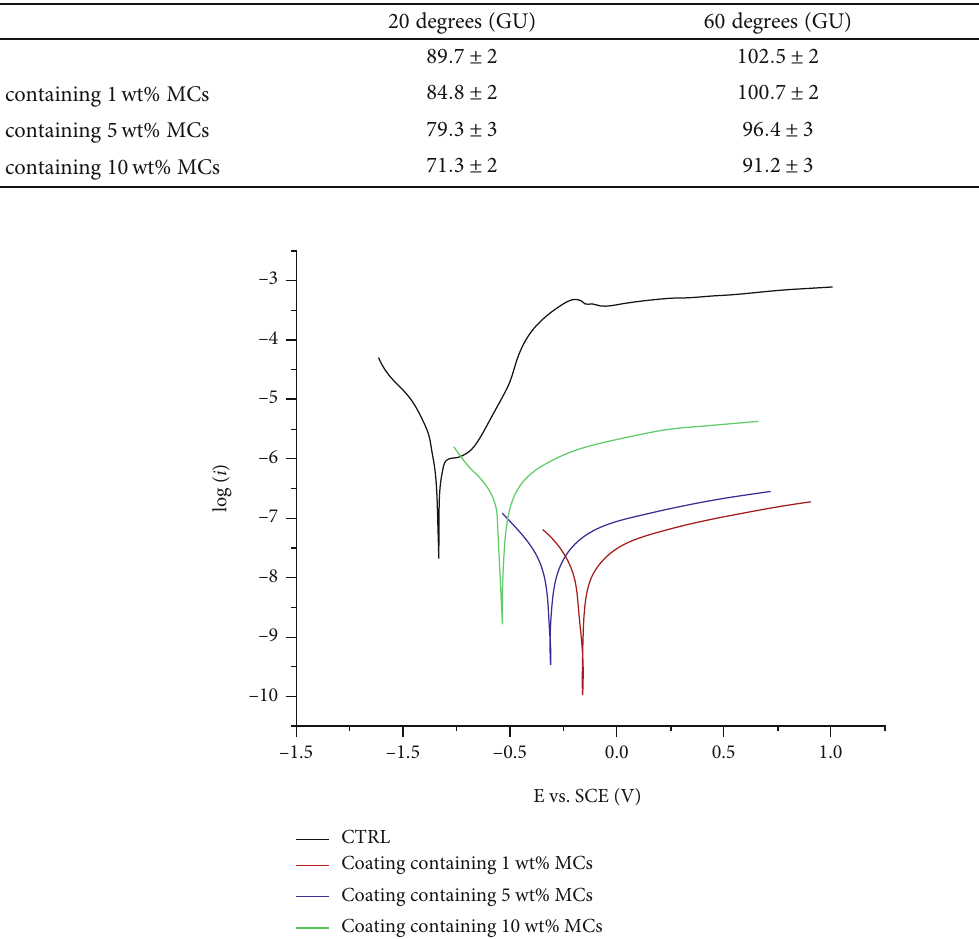
Figure 8: Potentiodynamic polarization curves for the scratched control and MC contained coatings after 14 days of immersion in 3.5% NaCl solution (0.785cm 2 circular contact area).